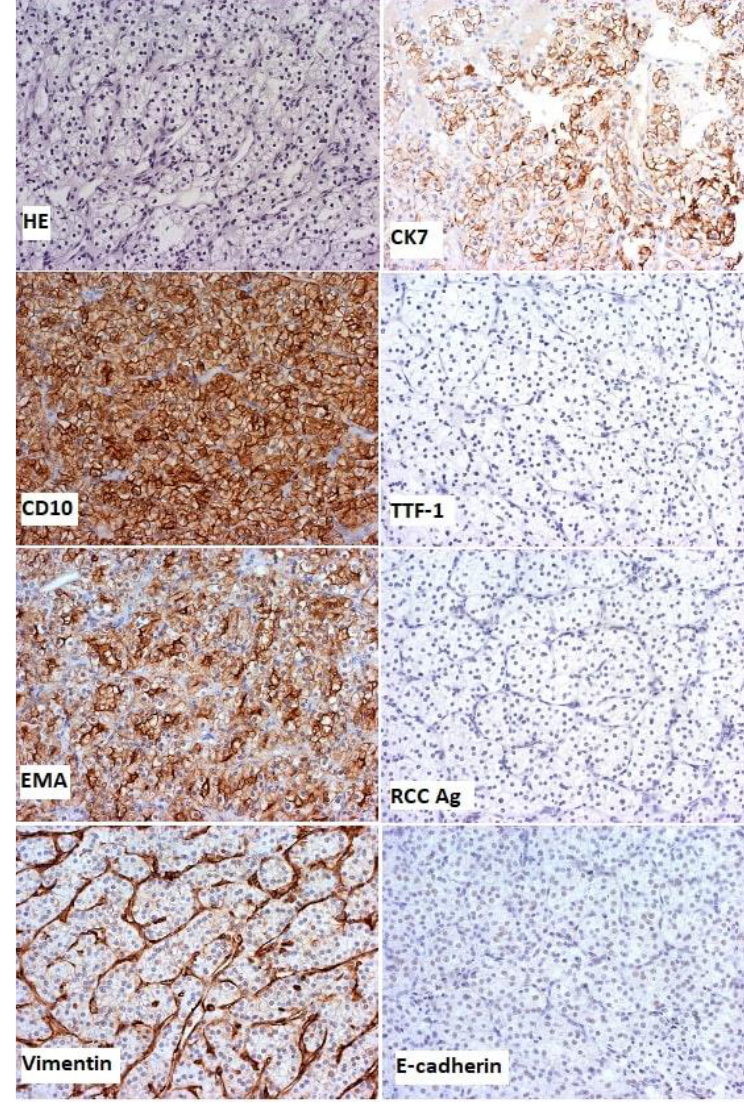
Figure 4. Histological examination, haematoxylin and eosin staining (HE), and immunohistochemical staining with magnification ×